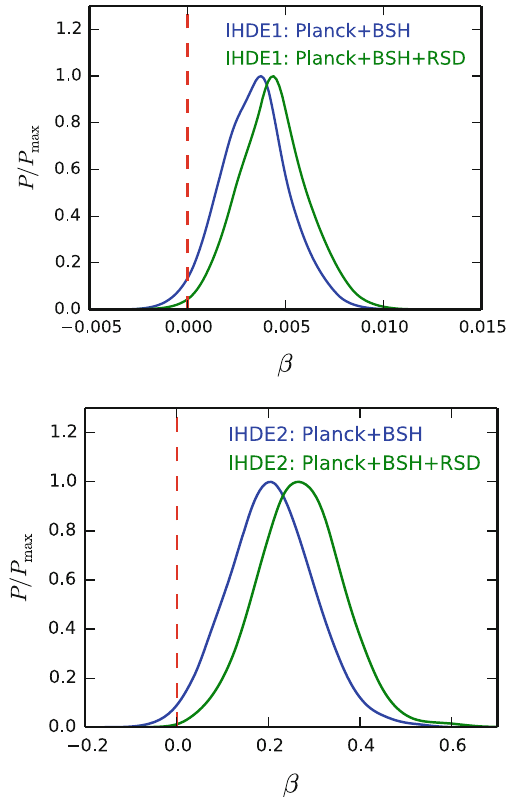
Fig. 4 Theone-dimensional posteriordistributions of β forthe IHDE1 ( Q = β H ρ c ) and IHDE2 ( Q = β H 0 ρ c ) models by using the Planck+BSH and Planck+BSH+RSD data